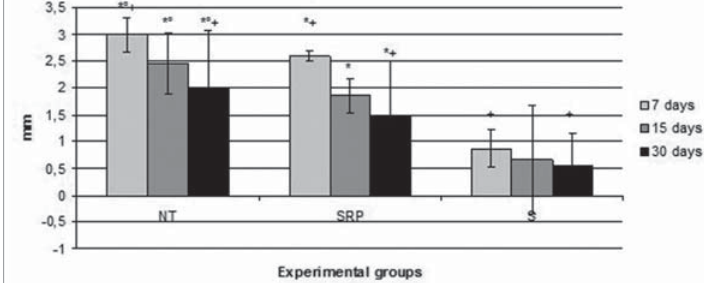
Figure 1- (cid:3)(cid:48)(cid:72)(cid:68)(cid:81)(cid:86)(cid:3)(cid:68)(cid:81)(cid:71)(cid:3)(cid:86)(cid:87)(cid:68)(cid:81)(cid:71)(cid:68)(cid:85)(cid:71)(cid:3)(cid:71)(cid:72)(cid:89)(cid:76)(cid:68)(cid:87)(cid:76)(cid:82)(cid:81)(cid:86)(cid:3)(cid:11)(cid:48)(cid:147)(cid:54)(cid:39)(cid:12)(cid:3)(cid:72)(cid:91)(cid:83)(cid:85)(cid:72)(cid:86)(cid:86)(cid:76)(cid:82)(cid:81)(cid:3)(cid:76)(cid:81)(cid:3)(cid:48)(cid:48)(cid:51)(cid:16)(cid:27)(cid:3)(cid:88)(cid:81)(cid:76)(cid:87)(cid:86)(cid:3)(cid:76)(cid:81)(cid:3)(cid:87)(cid:75)(cid:72)(cid:3)(cid:74)(cid:76)(cid:81)(cid:74)(cid:76)(cid:89)(cid:68)(cid:79)(cid:3)(cid:87)(cid:76)(cid:86)(cid:86)(cid:88)(cid:72)(cid:3)(cid:82)(cid:73)(cid:3)(cid:87)(cid:75)(cid:72)(cid:3)(cid:191)(cid:85)(cid:86)(cid:87)(cid:3)(cid:79)(cid:82)(cid:90)(cid:72)(cid:85)(cid:3)(cid:79)(cid:72)(cid:73)(cid:87)(cid:3)(cid:80)(cid:82)(cid:79)(cid:68)(cid:85)(cid:15)(cid:3)(cid:68)(cid:70)(cid:70)(cid:82)(cid:85)(cid:71)(cid:76)(cid:81)(cid:74)(cid:3) to each group and period